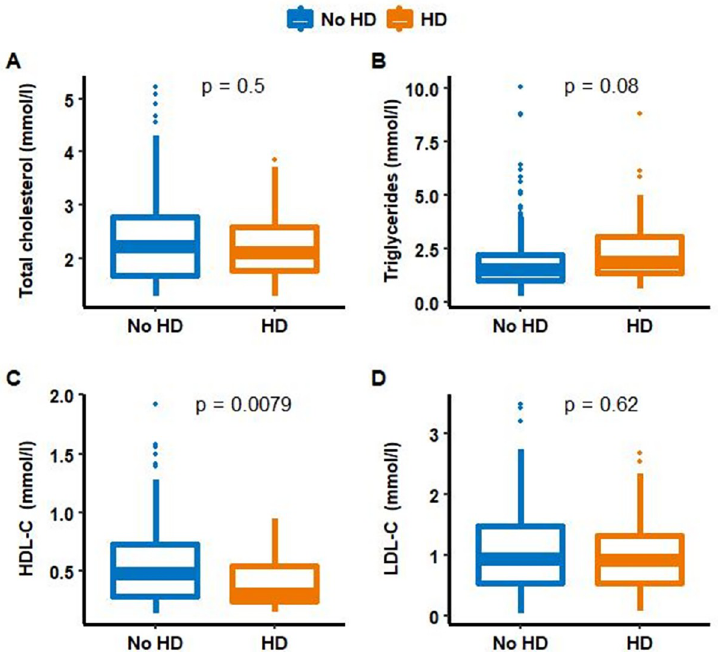
Fig 2. Comparison between total cholesterol, high-density lipoprotein-cholesterol, low-density lipoprotein- cholesterol and triglyceride concentrations at admission, according to hepatic dysfunction status. TC: total cholesterol, HDL-C: high-density lipoprotein-cholesterol, LDL: low-density lipoprotein-cholesterol, TG: triglycerides. HD: hepatic dysfunction.